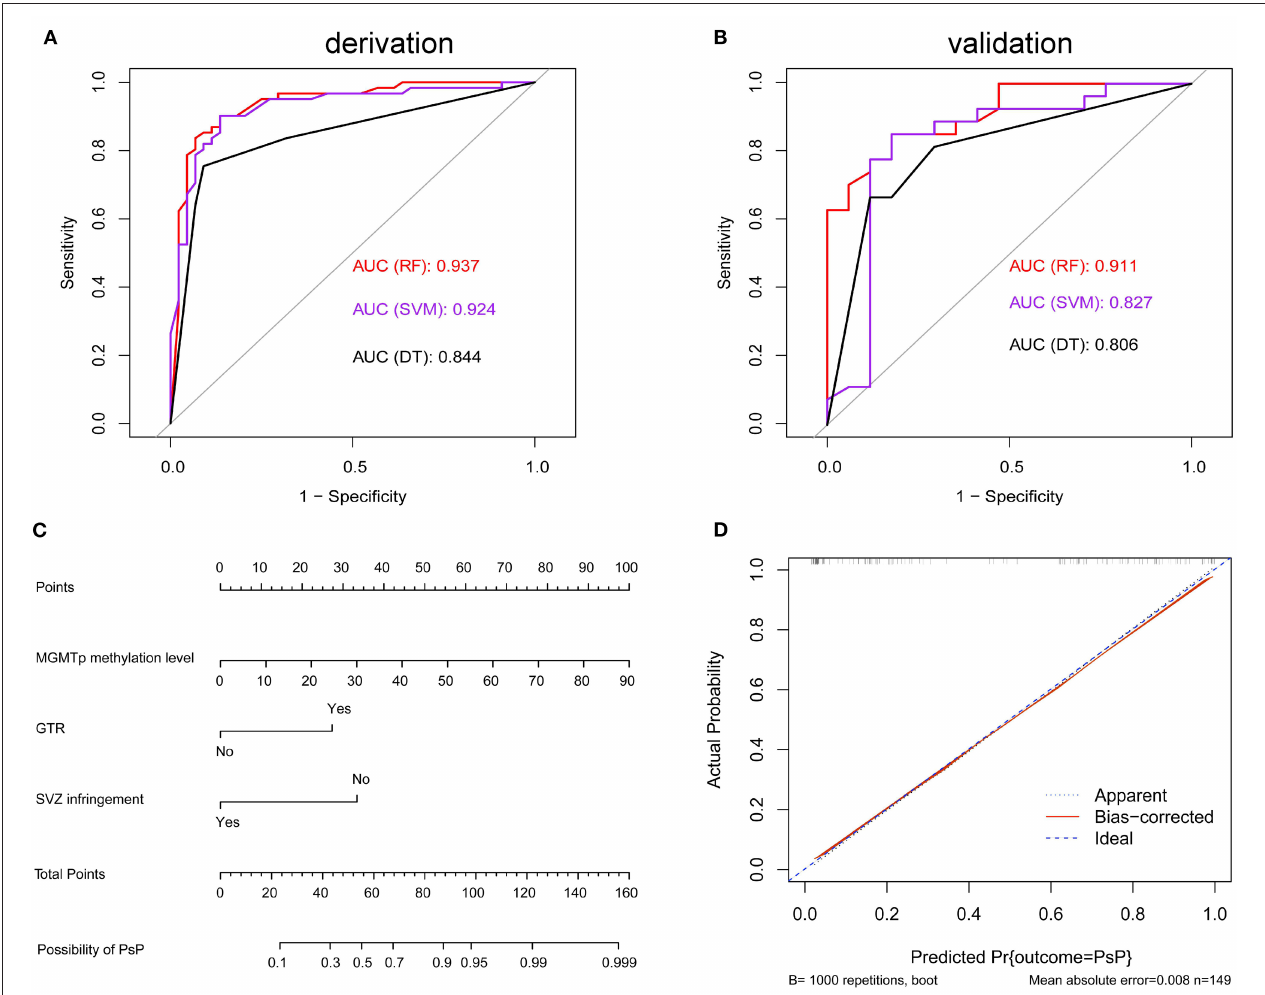
FIGURE 3 | Machine learning models in differentiating PsP from TeP and nomogram in predicting PsP. (A,B) Random forest (RF) model showed the best discriminative ability in derivation set [ k = 10, (A) ] and the validation set (B) . (C) The nomogram demonstrated the relationship between perioperative markers and the possibility of developing PsP. (D) Calibration plots graphically showed good agreement on the presence of PsP between the possibility estimated by the nomogram.